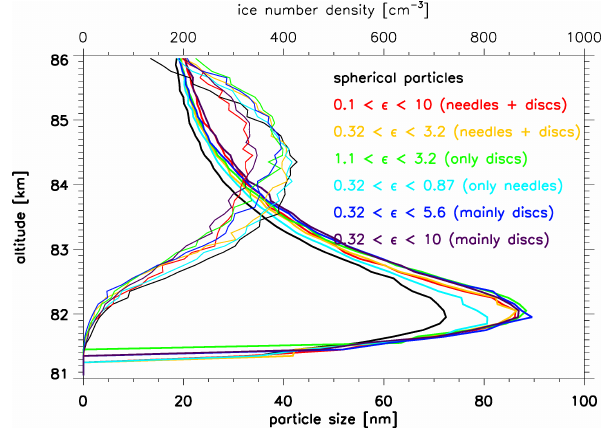
Figure 8. Simulated volume-equivalent radius and number density for a bright NLC event within 135–150 ◦ E, 67–72 ◦ N on 16 July 2009 at 24:00UT, with different shape distributions. Only particles > 15nm are included in the average of size and number